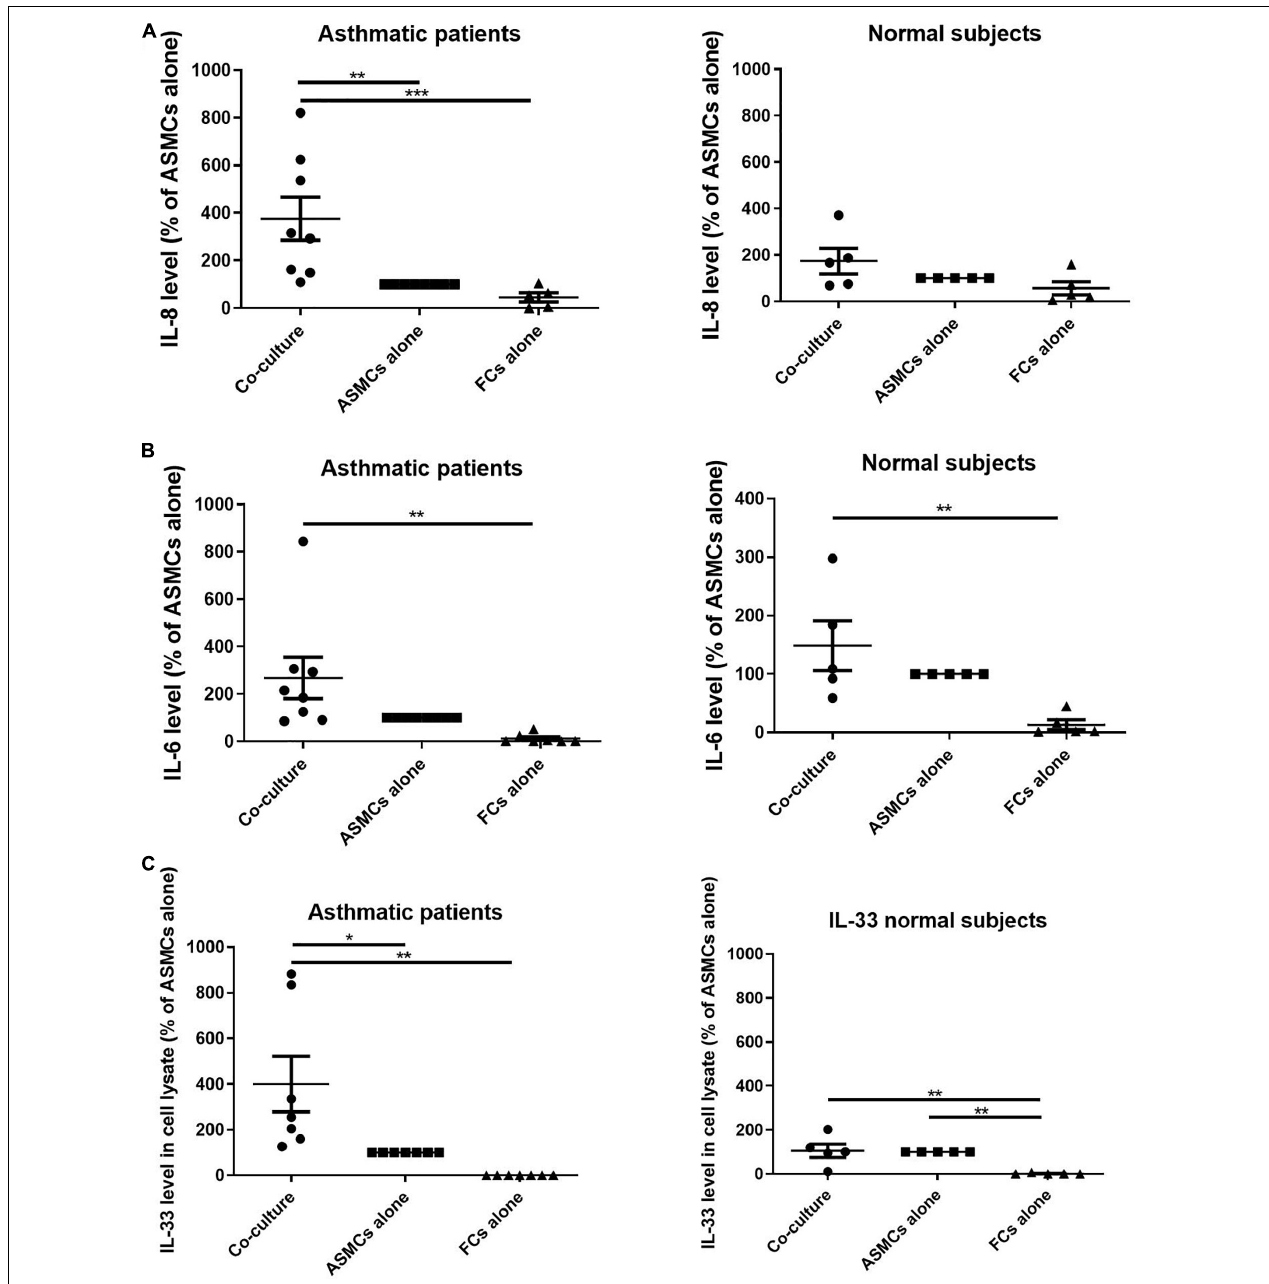
FIGURE 2 | (A) IL-8 levels and (B) IL-6 levels in the supernatant and (C) IL-33 levels in the cell lysates from the lower well in transwell experiments involving the co-culturing of ASMCs with fibrocytes, culturing ASMCs alone, and culturing fibrocytes alone. Fibrocytes were isolated from asthmatic patients or normal subjects. Cells were cultured at the same density in each well for 48 h and cytokine levels were detected using ELISA. The level of cytokines is presented as the% of ASMCs alone. p < 0.001, One-way ANOVA with Tukey’s multiple comparison test ( n = 5 ∼